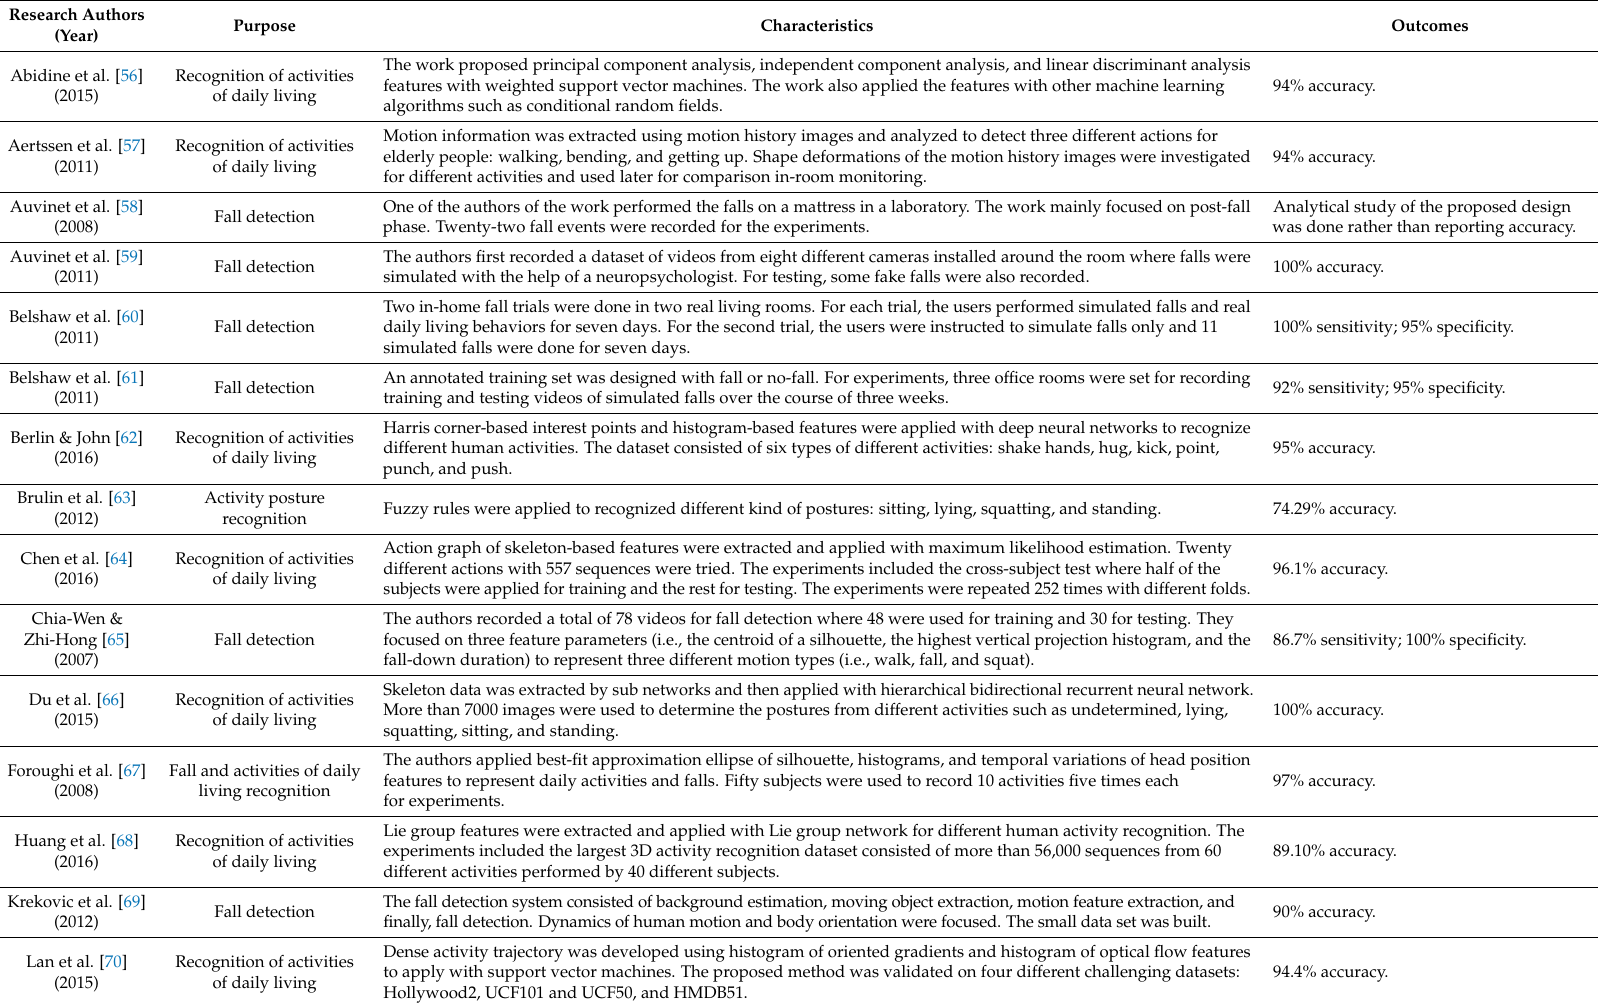
Table 3. Summary of research works that use video sensor